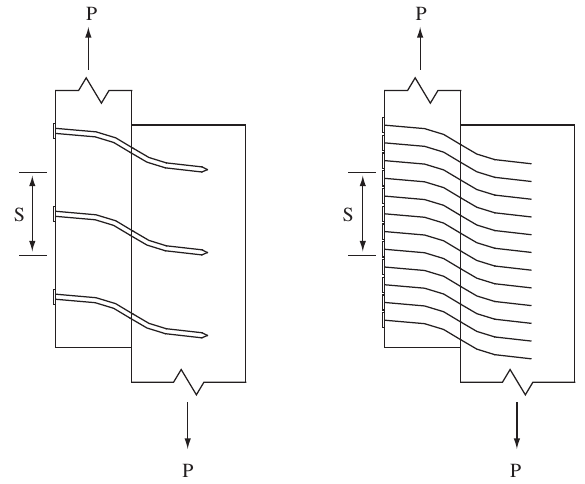
connection).PP PPS Figure 5. Two equivalent connections (real and fictitious